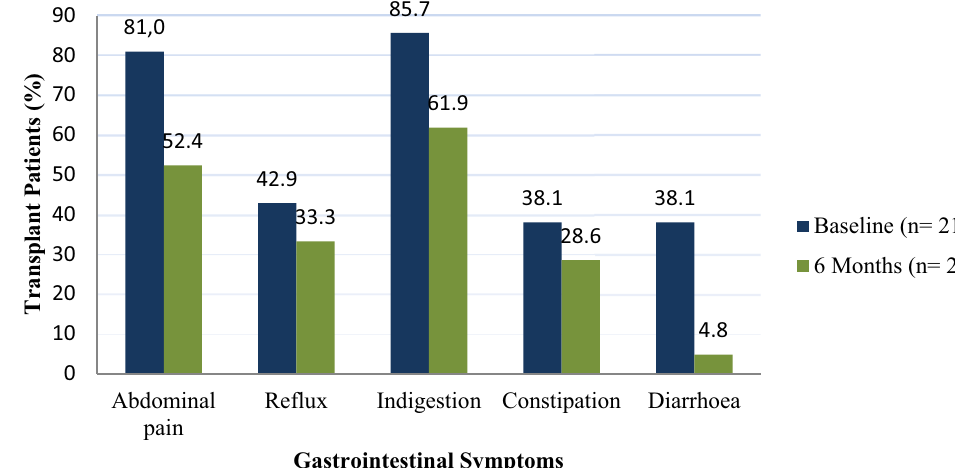
Figure 5. Frequency of gastrointestinal symptoms in transplant recipients at baseline and 6-month